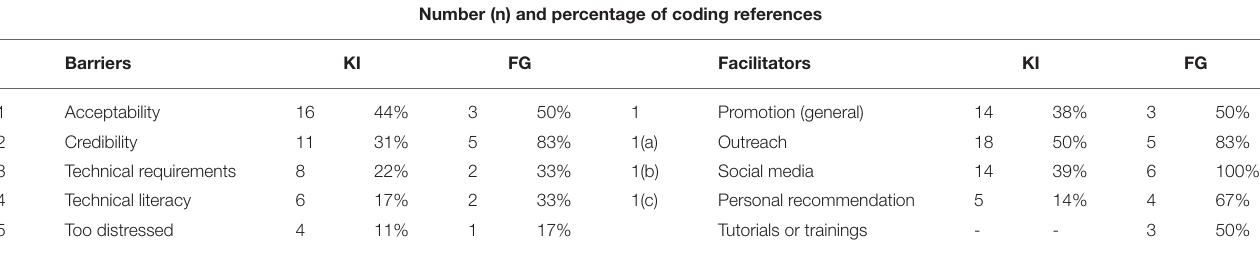
TABLE 5 | Overview of barriers and facilitators to use of the Step-by-Step app gathered through key informant interviews ( N = 36) and focus groups ( N = 6) in Germany, Sweden and Egypt (combined). Number (n) and percentage of coding